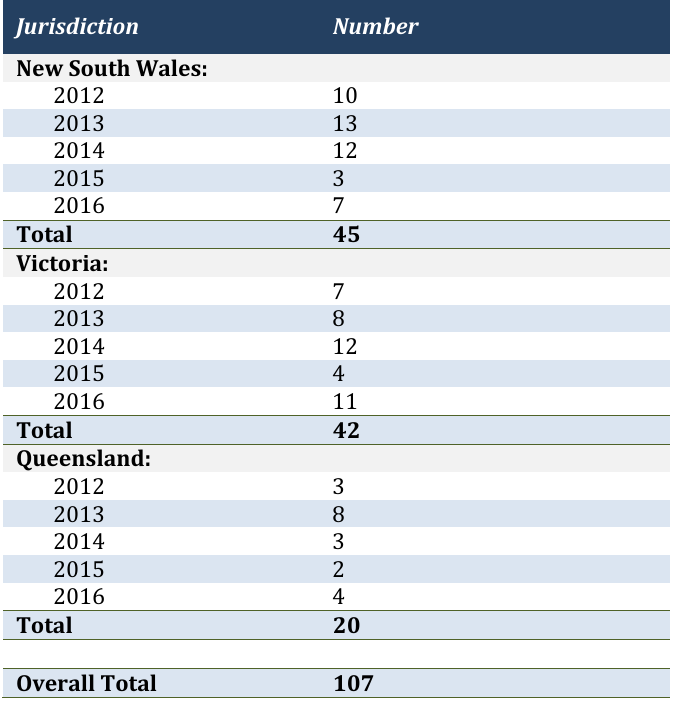
Table 2: Frequency of modalities of criminalisation for NSW, Victoria and Queensland (2012 ‐ 2016)